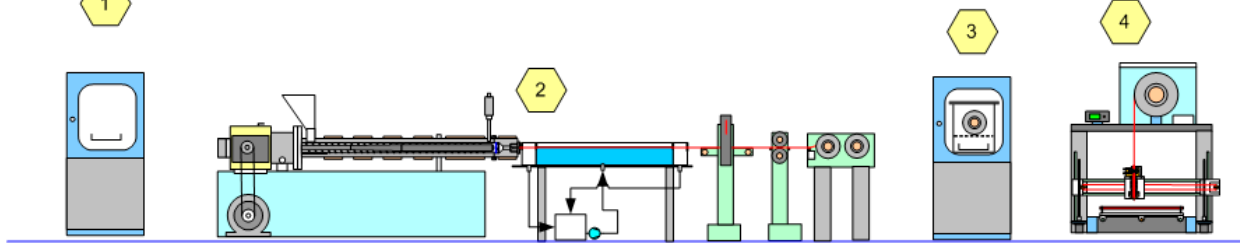
Figure 8. Principal process diagram of AM with PETG foaming: 1—initial material drying, 2—filament extrusion, 3—sorption of acetic acid ester, 4—additive manufacturing.